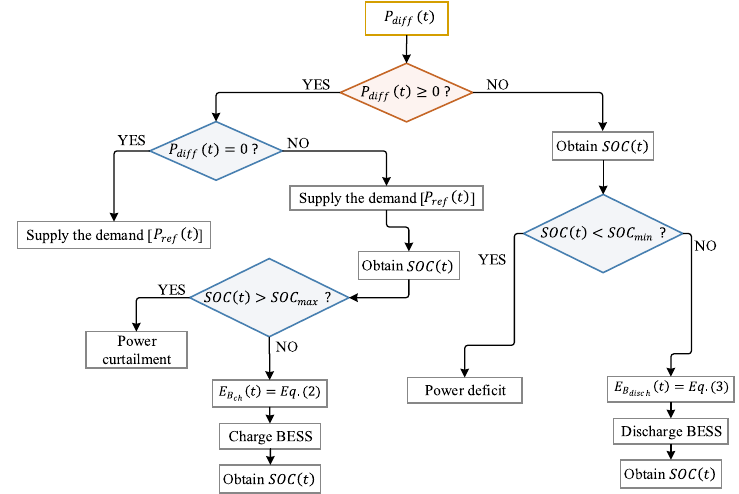
Figure 2. Energy management